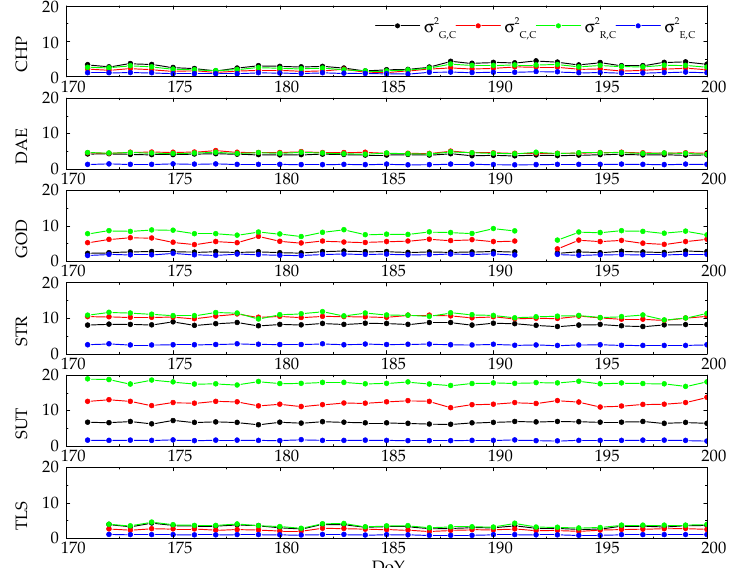
Figure 5. Daily average variance of unit weight of Multi-GNSS code observations in different baseline tests.